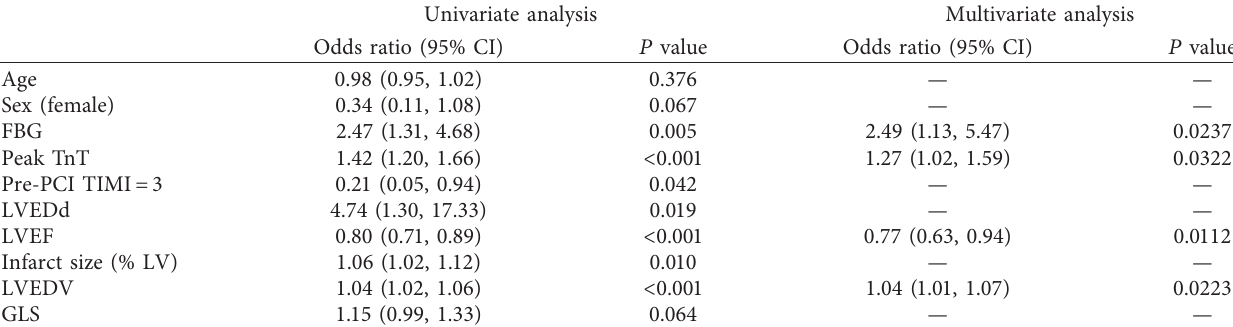
Table 3: Univariate and multivariate logistic analysis of predictors of MVO in nondiabetic STEMI patients after primary PCI. Univariate analysis Multivariate analysis